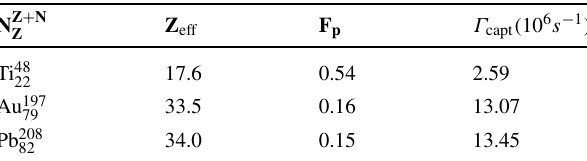
Table 21 Effective atomic number Z eff , nuclear form factor F p and capture rate Γ capt for the relevant